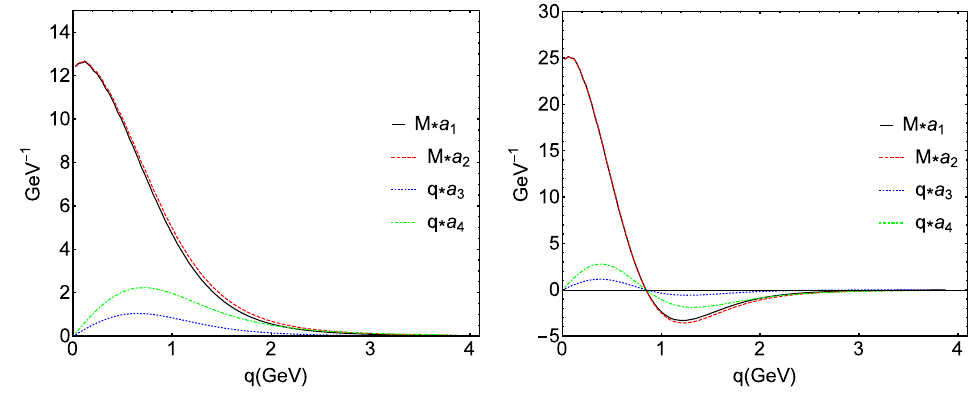
Figure 1 . The 0 − wave functions of the ground state B c (1 S ) (left) and the first excited state B c (2 S ) (right). a 1 and a 2 terms are S waves; a 3 and a 4 terms are P